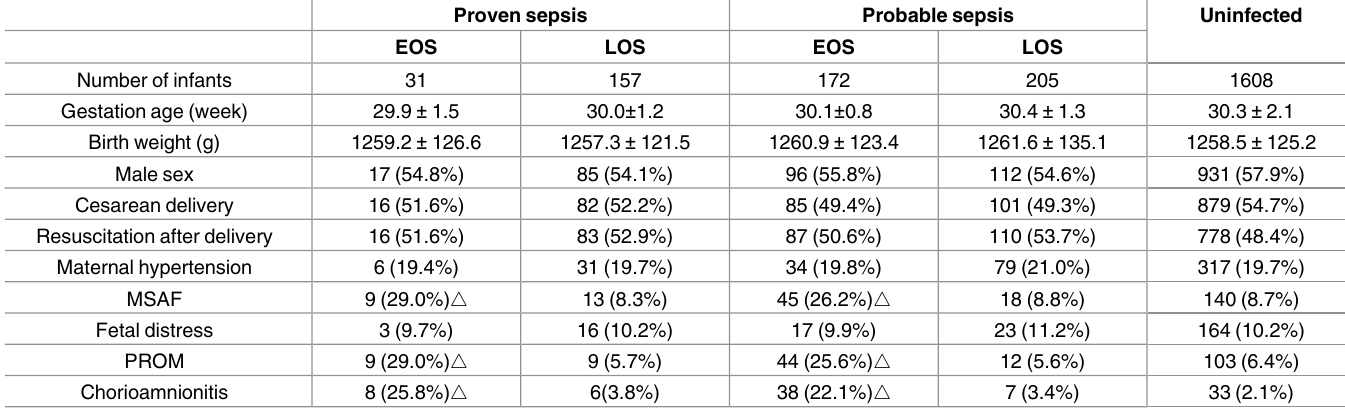
Table 1. Demographics, clinical variables, and distribution of neonates without and with probable and proven